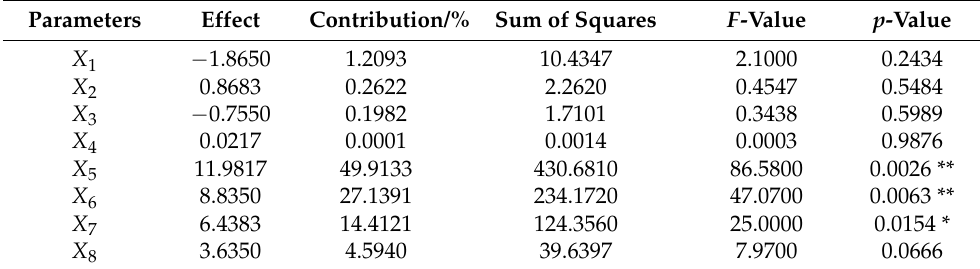
Table 4. Significant analysis of Plackett–Burman test parameters.